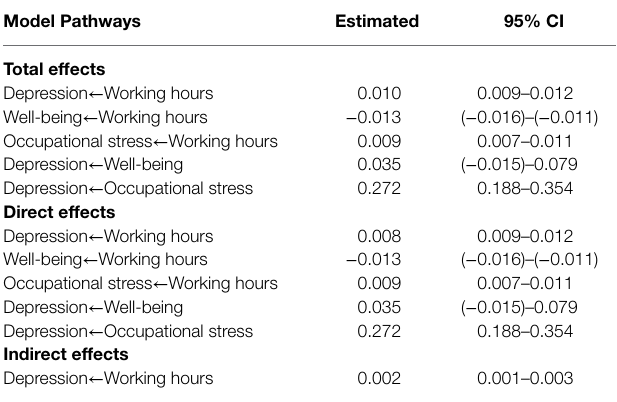
TABLE 3 | Significance test of the mediating test. TABLE 4 | Significance test of every mediating